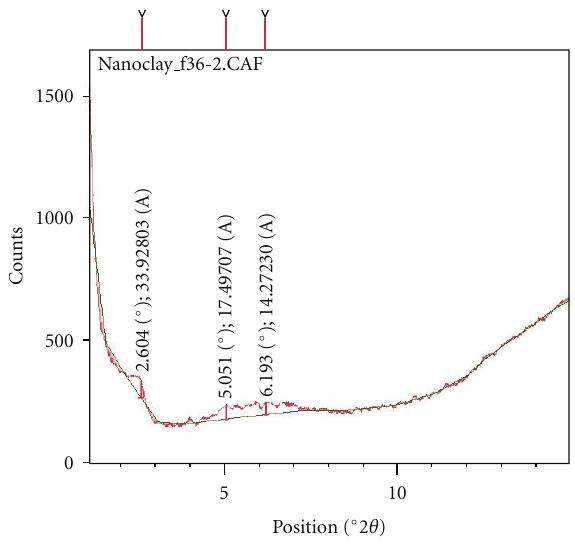
Figure 6: X-ray di ff raction curve of 1phr epoxy/organoclay nanocomposite under high-speed mixing